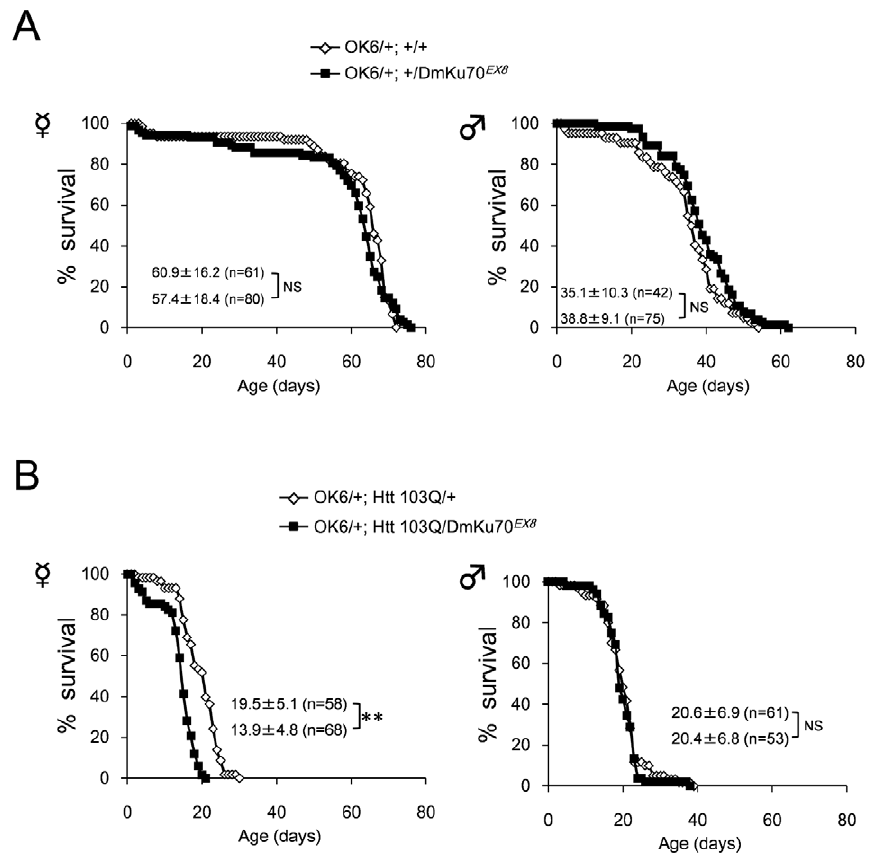
Figure 4. Reduction of DmKu70 enhances invivo toxicity of mutant Htt in Drosophila models. (A) Lifespan is not shortened by null mutation of endogenous DmKu70 in driver (OK6-Gal4/ + ) control background. The survival curve of heterozygous DmKu70 null mutant (filled square: OK6-Gal4/ + ; DmKu70 EX8 ) was similar to that of DmKu70 wt (open diamond:OK6-Gal4/ + ; DmKu70 + / + ). (B) Lifespan is shortened by null mutation of endogenous DmKu70 in female Htt model background (OK6-Gal4/ + ; UAS-Htt103Q/ + ). The survival of heterozygous DmKu70 null mutant (black square: OK6-Gal4/ + ; UAS-Htt103Q/ + ; DmKu70 EX8/ + ) was shorter than wt (open diamond: OK6-Gal4/ + ; UAS-Htt103Q/ + ; DmKu70 + / + ). Number of flies used for the experiments are 61 for OK6/ + females, 80 for OK6-Gal4/ + ; DmKu70 EX8/ + females, 58 for OK6-Gal4/ + ; UAS-Htt103Q/ + females, 68 for OK6- Gal4/ + ; UAS-Htt103Q/ + ; DmKu70 EX8/ + females, 42 for OK6/ + males, 75 for OK6-Gal4/ + ; DmKu70 EX8/ + males, 61 for OK6-Gal4/ + ; UAS-Htt103Q/ + males and 53 for OK6-Gal4/ + ; UAS-Htt103Q/ + ; DmKu70 EX8/ + males. The genetic background for female flies was w 1118 derived from Bloomington Drosophila Stock Center. For male flies, the 2nd chromosome was w (CS10) and the 3rd chromosome was w 1118 and the X chromosome was the mixture of w (CS10) and w 1118 . The average lifespan and SD are shown. **p , 0.01, Wilcoxon’s test.